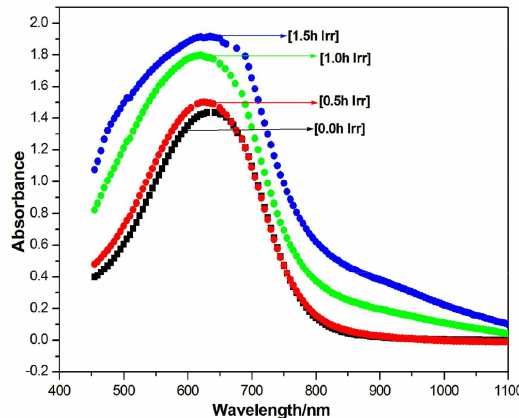
Figure 2. UV-Visible graph of composite after different intervals of irradiation.